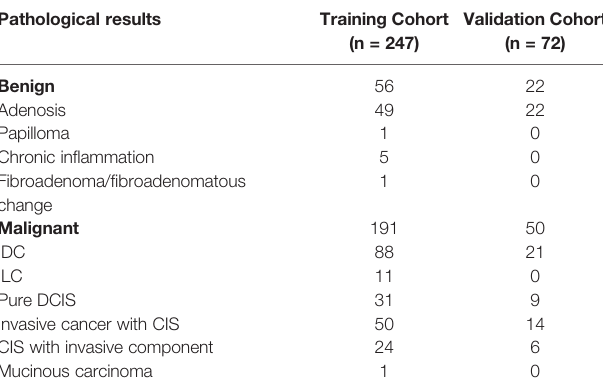
TABLE 1 | Pathologic fi ndings for all non-mass enhancement (NME)